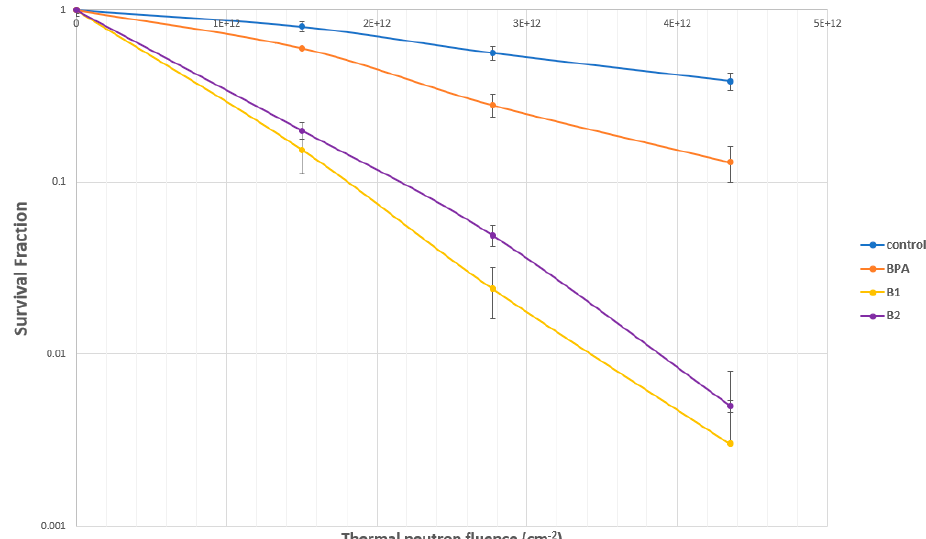
Figure 6. Cell survival fraction of SCC VII after in vitro BNCT with hydroxamates 1 ( B1 ) and 2 ( B2 ). The absorbed dose yielding the D37 (dose used to inhibit 63% colony formation) values were 0.27 Gy for 1 ( B1 ), 0.32 Gy for 2 ( B2 ), 0.82 Gy for BPA, and 1.55 Gy for boron-free control. The relative killing e ff ect of B1 to BPA is 0.82/0.27 = 3.0, and that of B2 is 0.82/0.32 = 2.6.